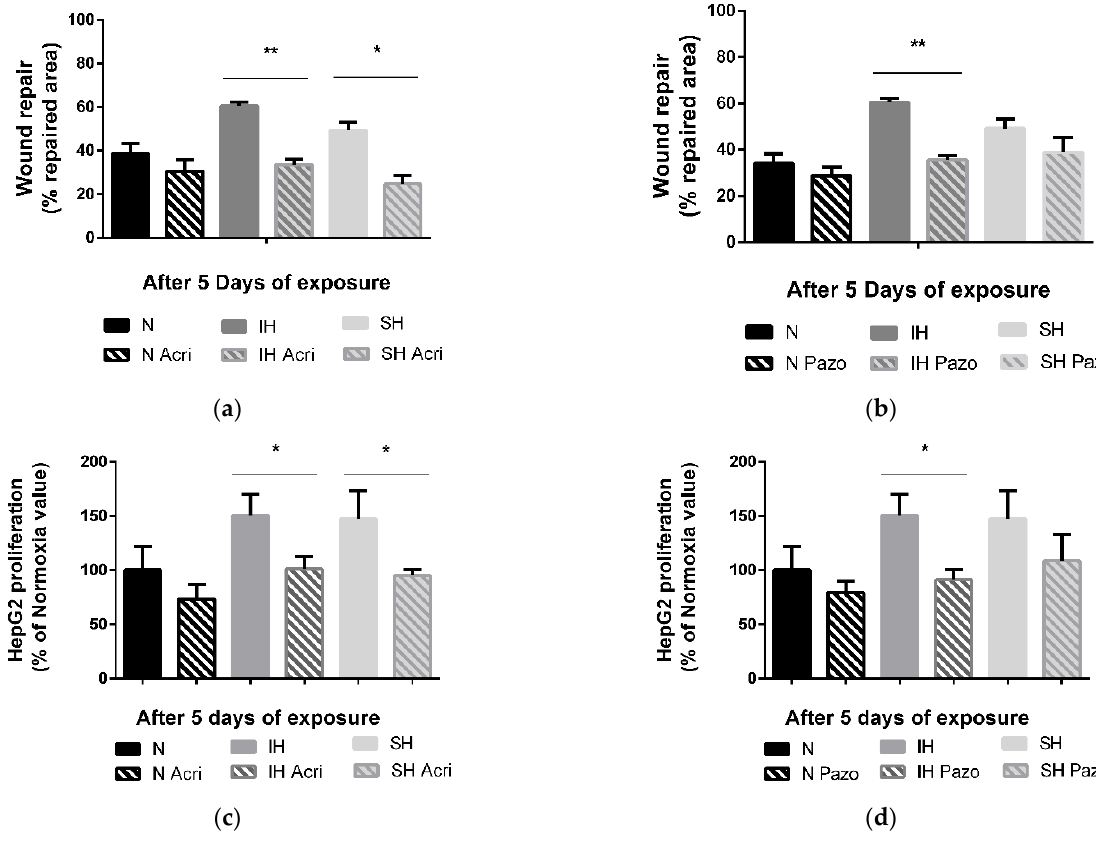
Figure 4. Effects of acriflavine and pazopanib on wound healing and proliferation under sustained hypoxia or intermittent hypoxia. ( a ) Wound healing, expressed as % of repaired area, of HepG2 cells exposed to 5 days of normoxia (N), intermittent hypoxia (IH) or sustained hypoxia (SH) and treated or not by acriflavine (Acri); n = 3 experiments per group with at least 3 wells/experiment. ** p < 0.01 on D5 for IH acriflavine-treated cells compared with IH untreated and * p < 0.05 on D5 for SH acriflavine-treated cells compared with SH untreated cells, Mann–Whitney U test. ( b ) Wound healing, expressed as a % of repaired area, of HepG2 cells exposed to 5 days of normoxia, intermittent hypoxia or sustained hypoxia and treated or not by pazopanib (Pazo); n = 3 experiments per group with at least 3 wells/experiment. ** p < 0.01 on D5 for IH pazopanib-treated cells compared with IH untreated, Mann–Whitney U test. ( c ) Proliferation, expressed as a % of Normoxia values, of viable HepG2 cells quantified by MTT staining after 5 days of normoxia, intermittent hypoxia or sustained hypoxia and treated or not by acriflavine (Acri); n = 3 independent experiments/group, 6 to 12 wells/group: at least 2 wells/experiment. * p < 0.05 on D5 for IH acriflavine-treated cells compared with IH untreated, p < 0.05 for CH acriflavine-treated cells compared with CH untreated cells, Mann–Whitney U test. ( d ) Proliferation, expressed as a % of control values (respectively N, IH or CH), of viable HepG2 cells quantified by MTT staining after 5 days of normoxia, intermittent hypoxia or sustained hypoxia and treated or not by pazopanib (Pazo); n = at least 3 independent experiments/group (9 wells/group: at least 2 wells/experiment). * p < 0.05 on D5 for IH pazopanib-treated cells compared with IH untreated, Mann–Whitney U test.